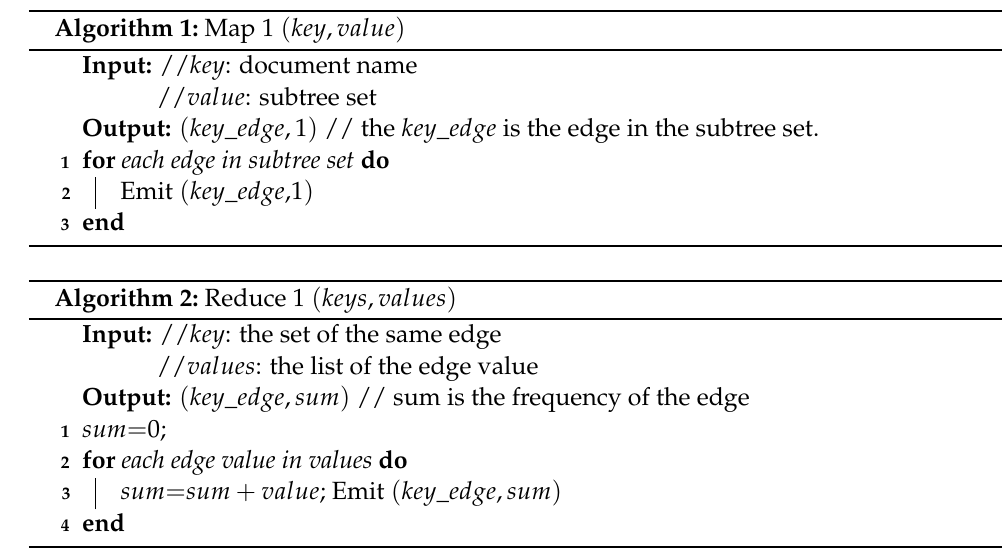
Algorithm 1: Map 1 ( key , value )